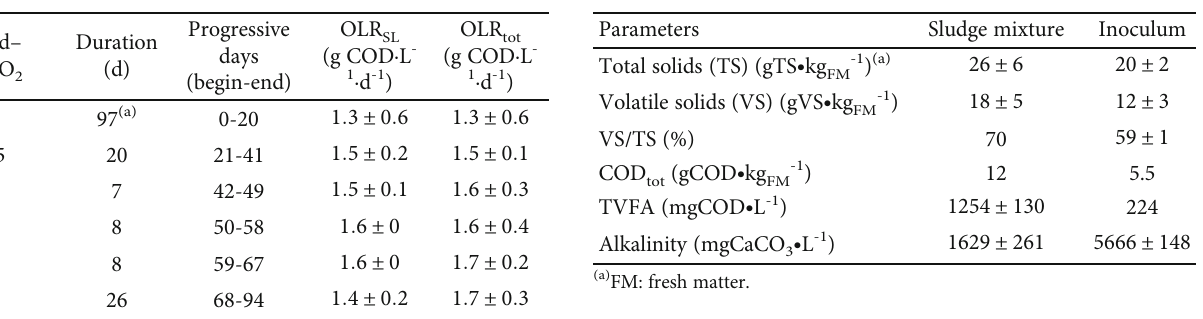
Table 1: Operational parameters during experimental periods; in brackets, next to the period number, the H